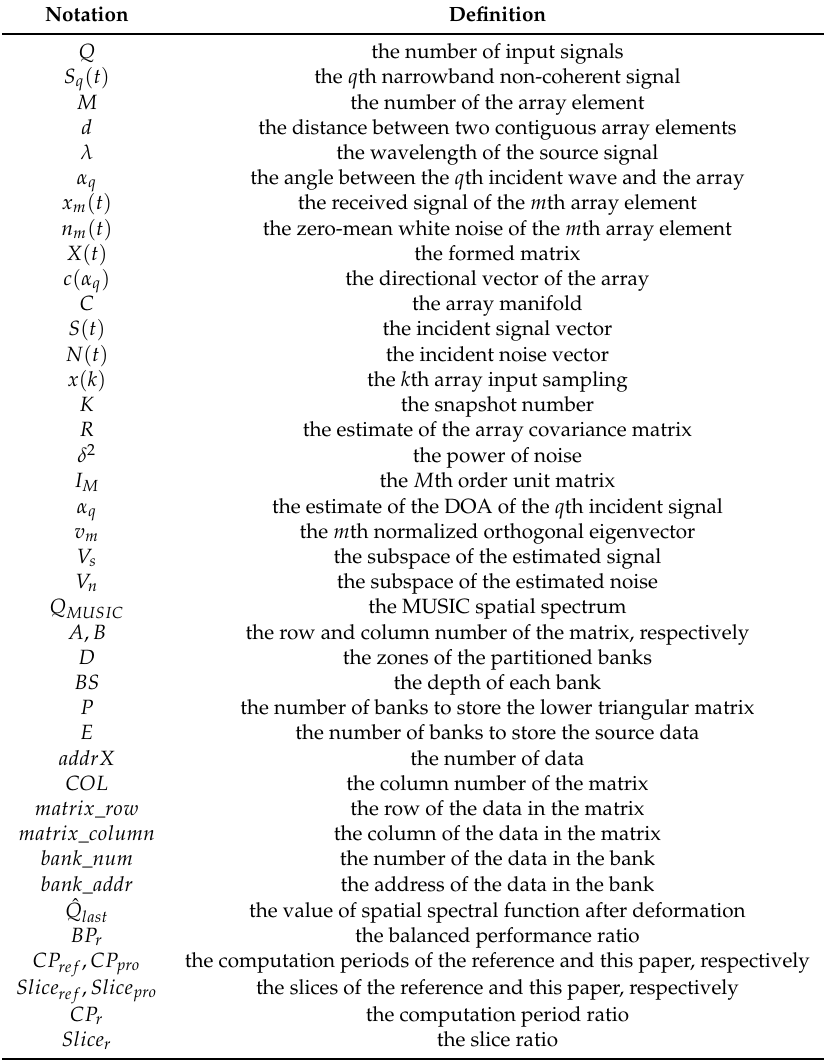
Table 1. Notations in this